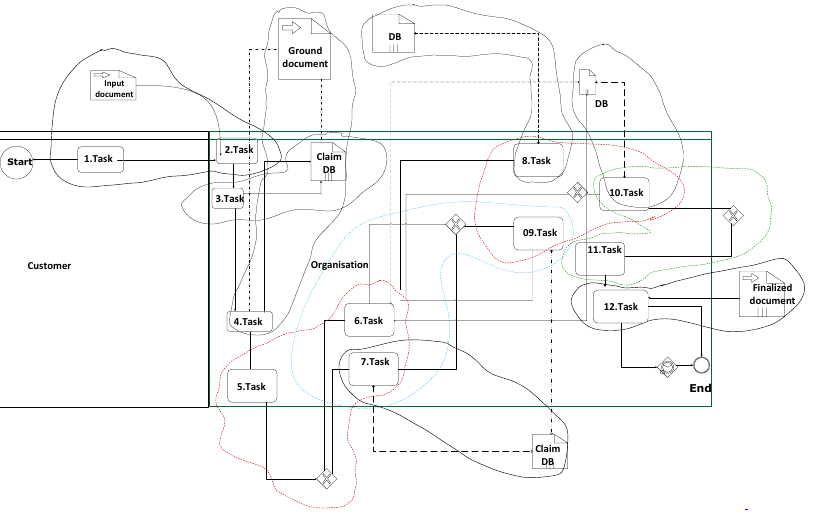
Figure 13. Transforming into adequate hyper-graph components: logical inference and document